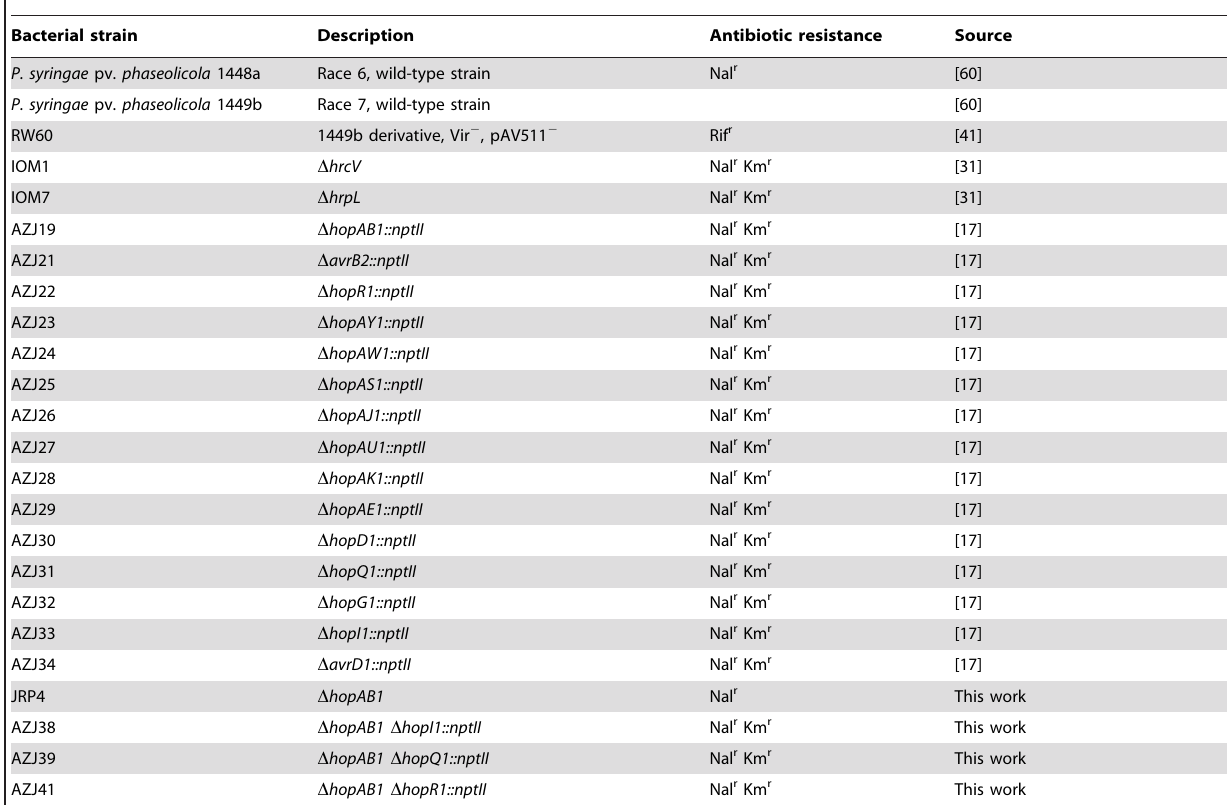
Table 1. Bacterial strains used in this work.